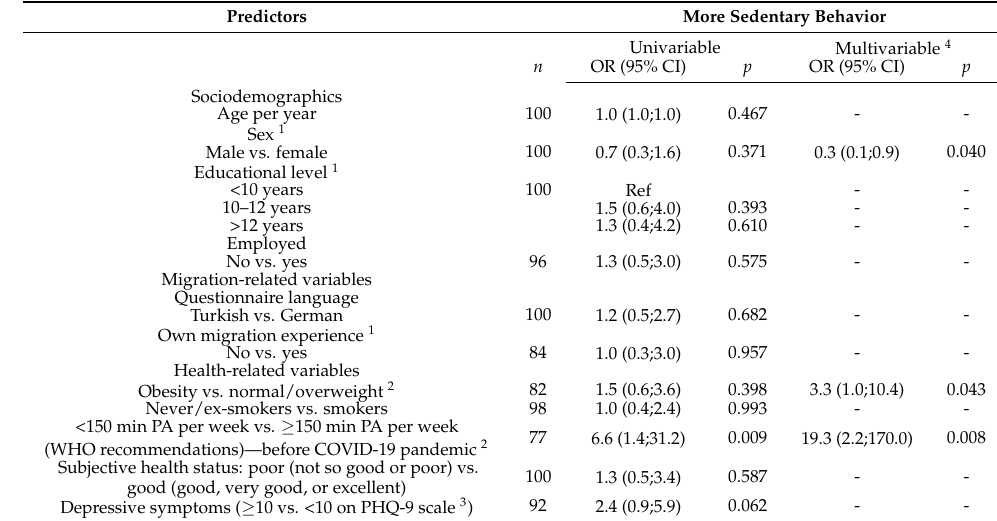
Table 3. Univariable and multivariable regression analysis for the outcome more sedentary behavior during the COVID-19